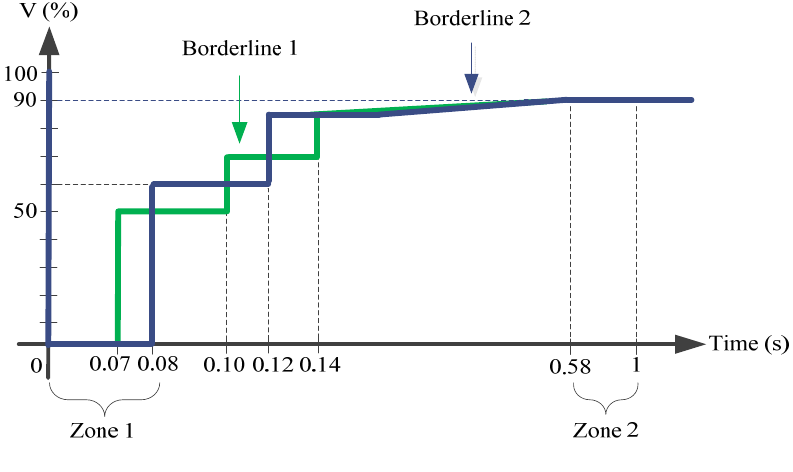
Figure 5. LVRT profile in the UK’s grid code for short circuits of up to 140 ms in